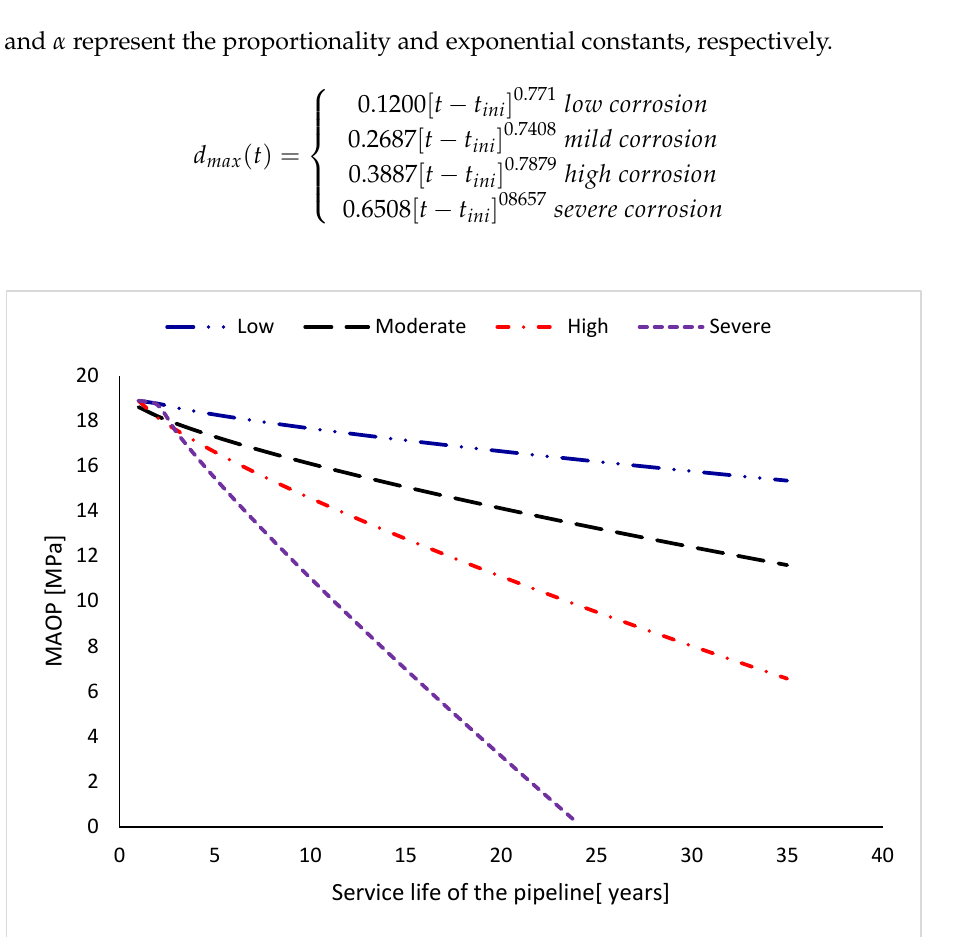
Figure 11. Predicted Maximum Allowable Operating Pressure (MAOP) for a 323.6 mm diameter and 8.51 mm thick pipeline with a 105 mm-long corrosion defect and an ultimate tensile strength of 469.27 MPa using Equation (12a).